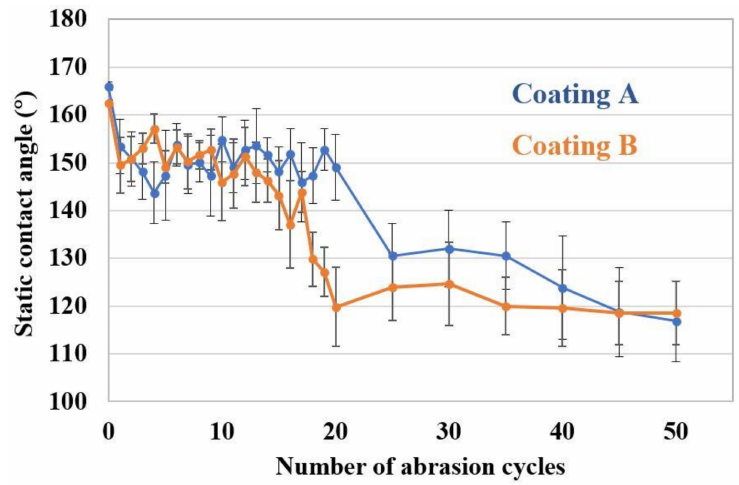
Figure 6. Static contact angles after abrasion against a 240-grit sandpaper with 7.75 kPa normal load.